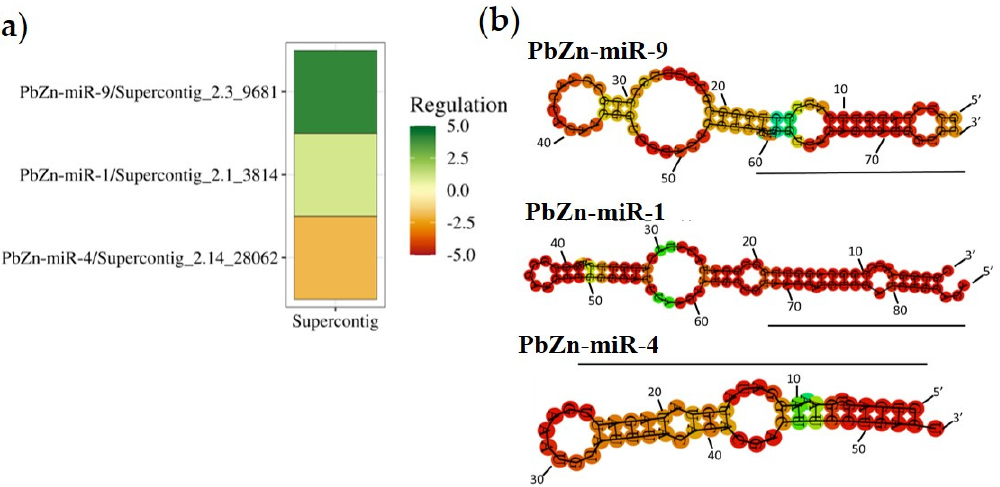
Figure 1. Heat map and image of differentially expressed microRNAs during zinc deprivation. ( a ) Heat map: The significant miRNAs observed are plotted with a fold change value in each color-coded histogram, with the grades of green for up-regulated genes and grades of red for down- regulated genes. ( b ) Structural representation of differentially expressed microRNAs.